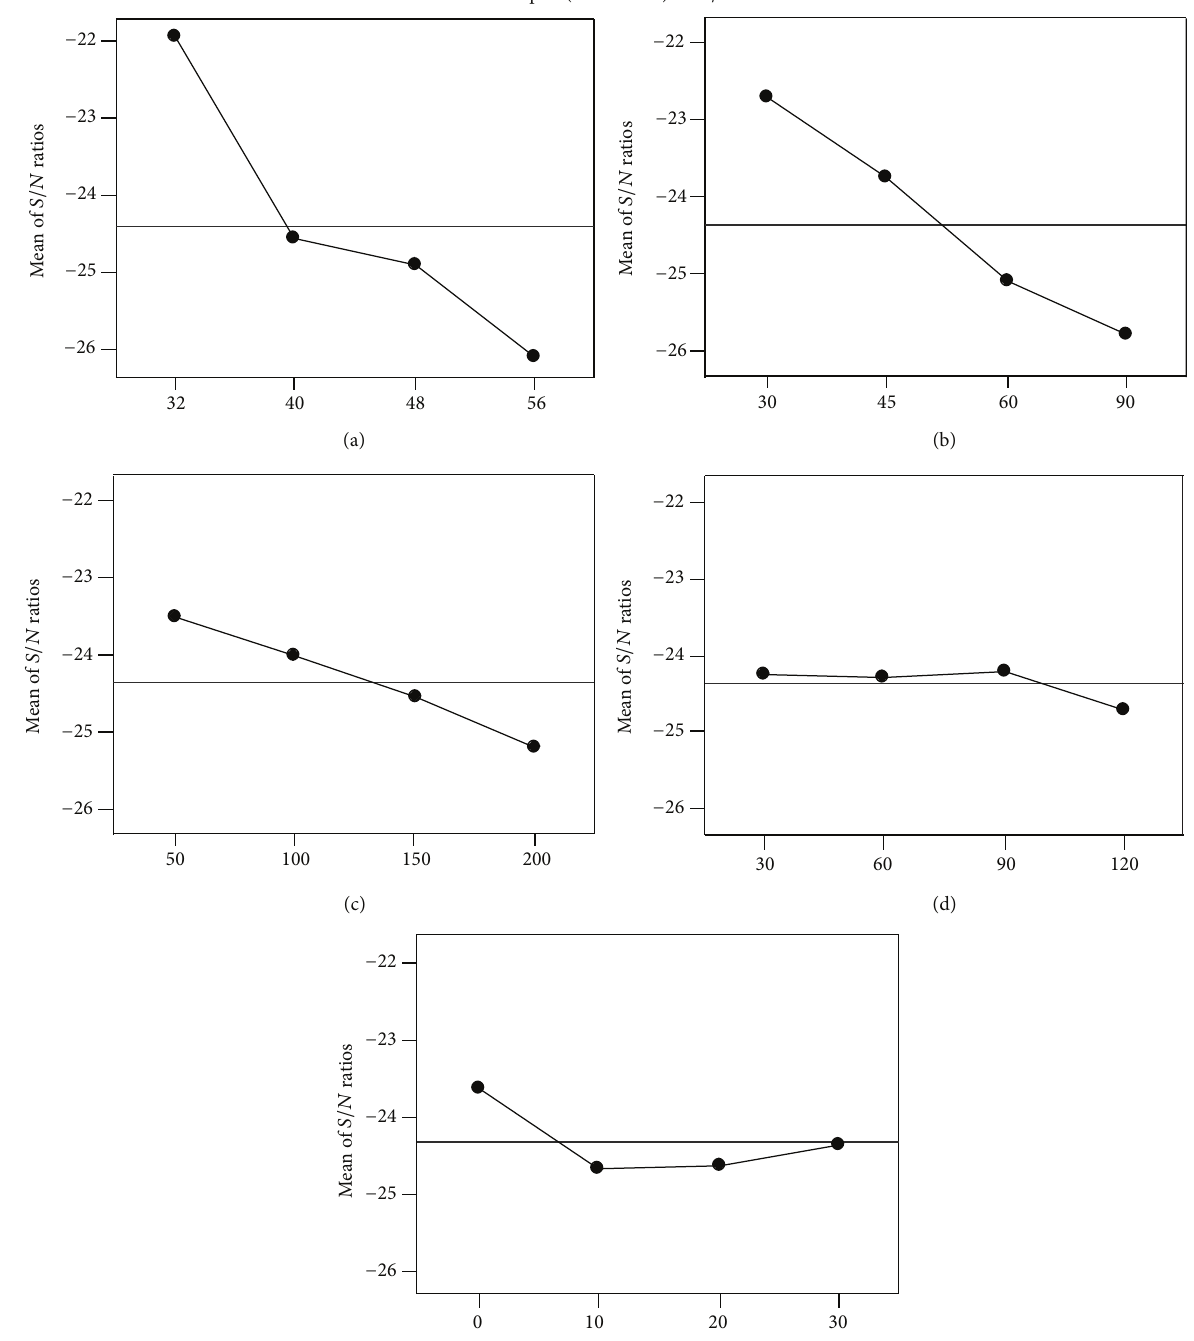
Figure 6: Main effect plot for 𝑆/𝑁 ratio. Signal-to-noise: